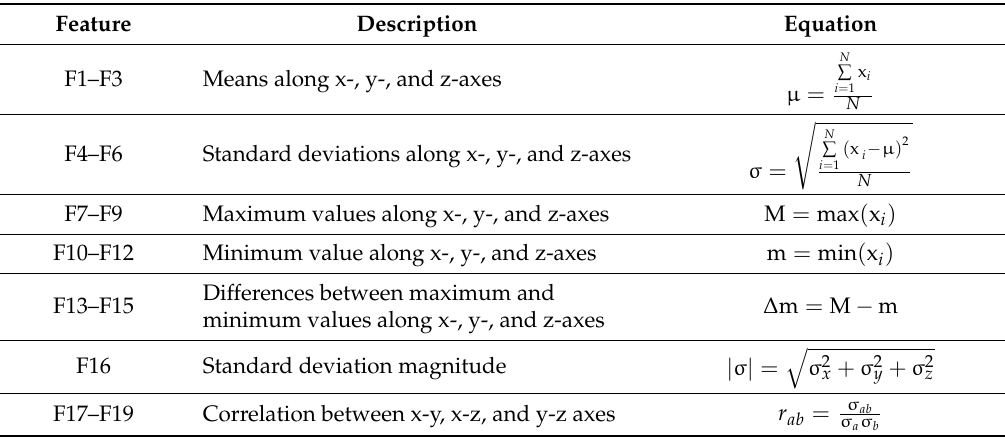
Table 1. List of features and their equations.